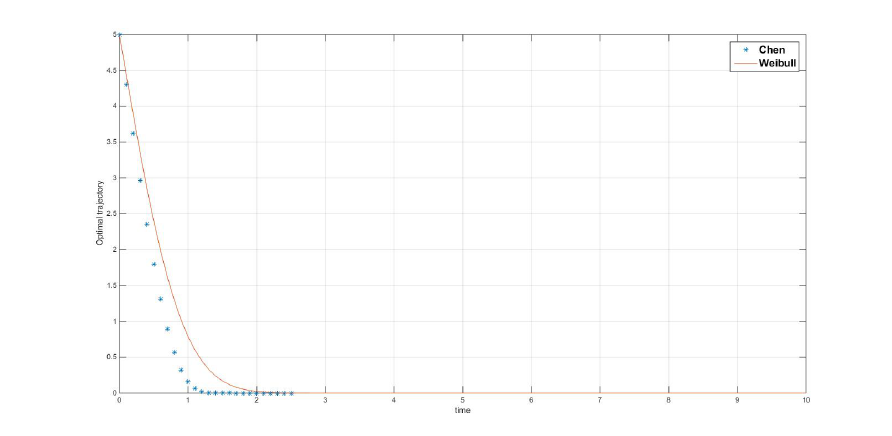
Figure 7. Optimal trajectories for laws of Weibull (continous-red) and Chen (dotted-blue) when δ 1 = 2 = δ 2 and λ 1 = 1 = λ 2